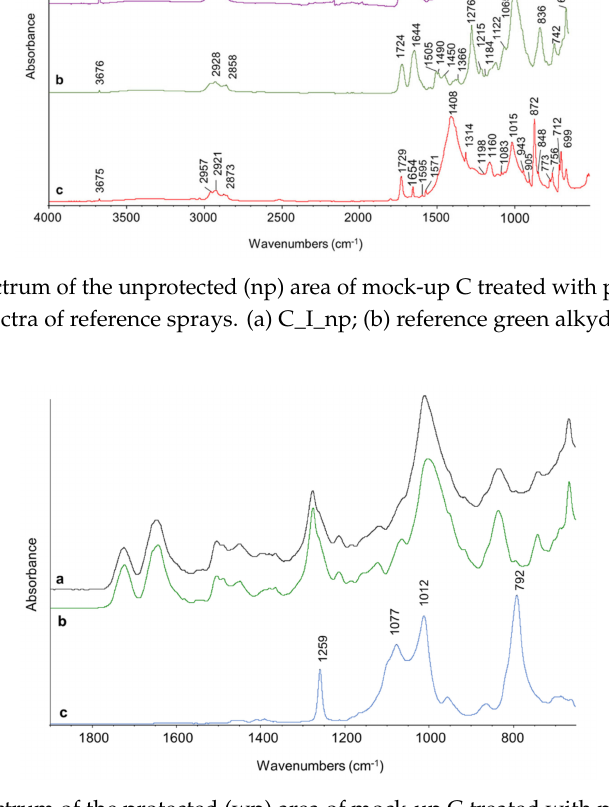
Figure 9. FTIR spectrum of the protected (wp) area of mock-up C treated with propylene carbonate, compared with spectra of the reference green alkyd spray and of the protective coating. (a) C_I_wp; (b) reference green alkyd spray; (c) protective